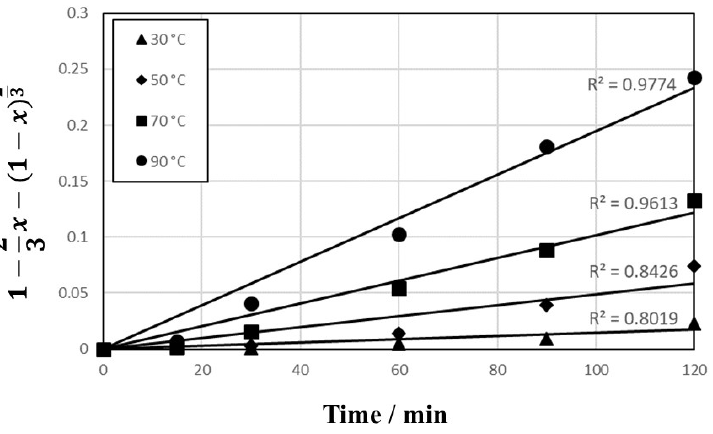
Figure 9. Plot of 1 − 2/3 x − (1 − x ) 2/3 vs. T as a function of time for Cu leaching at temperature 30–90 °C in 1 mol/L sulfuric acid solution.